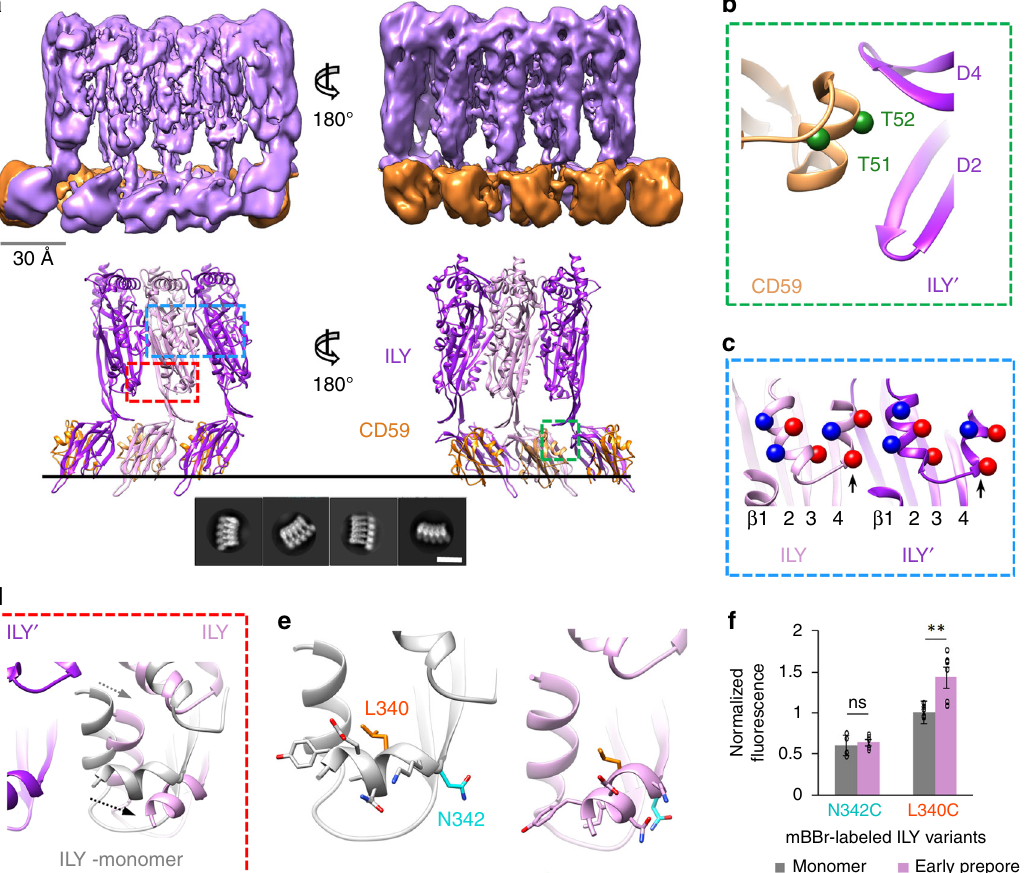
Fig. 1 Structure of an ILY – CD59 early prepore oligomer. a CryoEM reconstruction fi ltered according to local resolution (top) and structural model derived from the cryoEM density map (bottom). In the model, adjacent ILY monomers (ILY and ILY ′ ) are pink and purple, respectively. Neighboring CD59 molecules are orange. Black line represents the membrane surface. Dashed boxes indicate regions highlighted in panels ( b ) (green), ( c ) (blue), and ( d ) (red). Bottom inset shows a selection of 2D class averages. White scale bar, 100 Å. b Interaction interface between CD59 and domains 2 and 4 (D2, D4) of neighboring ILY ′ . Green spheres indicate positions of residues modi fi ed by O-linked glycans in endogenous CD59 (T51, T52). c Helix-turn-helix motif of the oligomeric early prepore. Newly formed helix of ILY (formerly β -strand 5) is indicated by black arrow. Spheres indicate negative (red) and positive (blue) charged residues within the helices. β -strands of the MACPF/CDC domain are labeled. d Superposition of the early prepore ILY (pink) with monomeric ILY (gray) from crystal structure PDBID: 4BIK 17 . Gray and black arrows indicate direction of shifts for the vertical and horizontal helix (h-helix), respectively. Neighboring ILY ′ is shown for reference. e Structural model showing the location of residues L340 (orange) and N342 (cyan) modi fi ed by the fl uorescent tag, mBBr. Sidechains have been added in COOT 44 for visualization purposes. f Normalized fl uorescence intensity of mBBr-labeled h-helix residues in monomeric (gray) and oligomeric early prepore (pink) ILY. Individual data points from six independent experimental assays are shown as circles, error bars represent standard deviation with the center of the bar indicating the mean value, p -value signi fi cance determined by a two-sided Student ’ s t test: ns, not signi fi cant, p = 0.19; ** p =